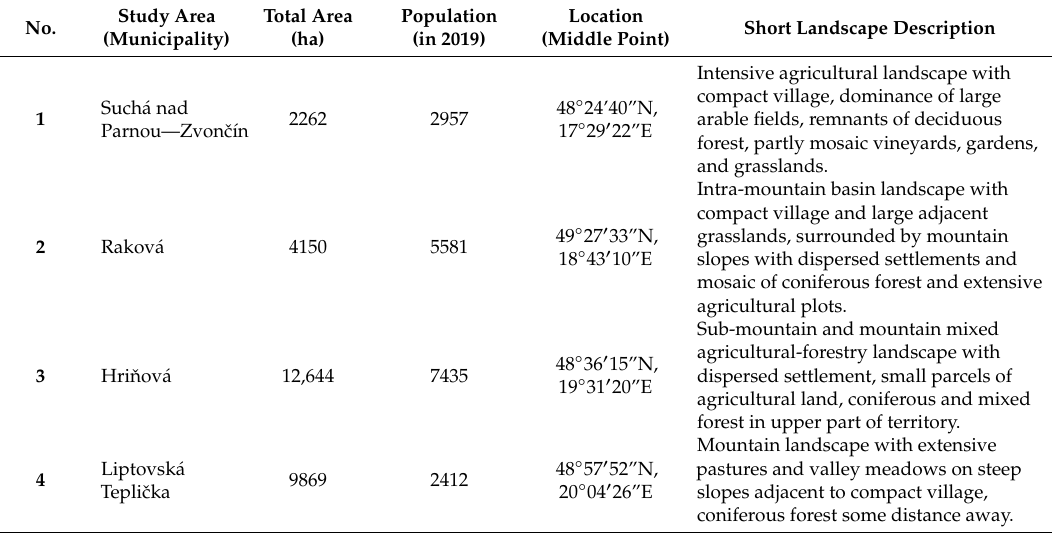
Table 1. The total area, number of inhabitants, and the location and landscape structural character of all study